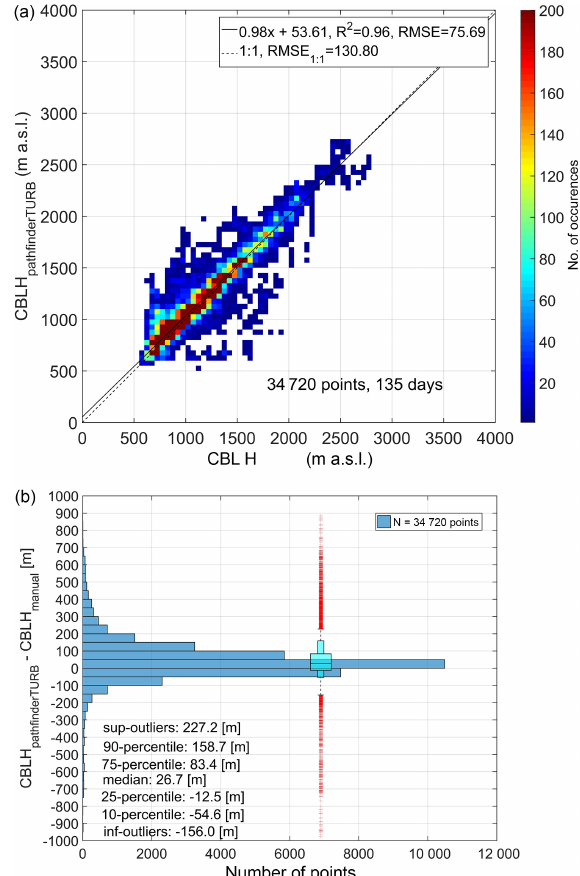
Figure 3. Density scatter plot of CBLH PathfinderTURB versus CBLH manual ( a ). Box plot and histogram of the difference between the PathfinderTURB and manual datasets ( b